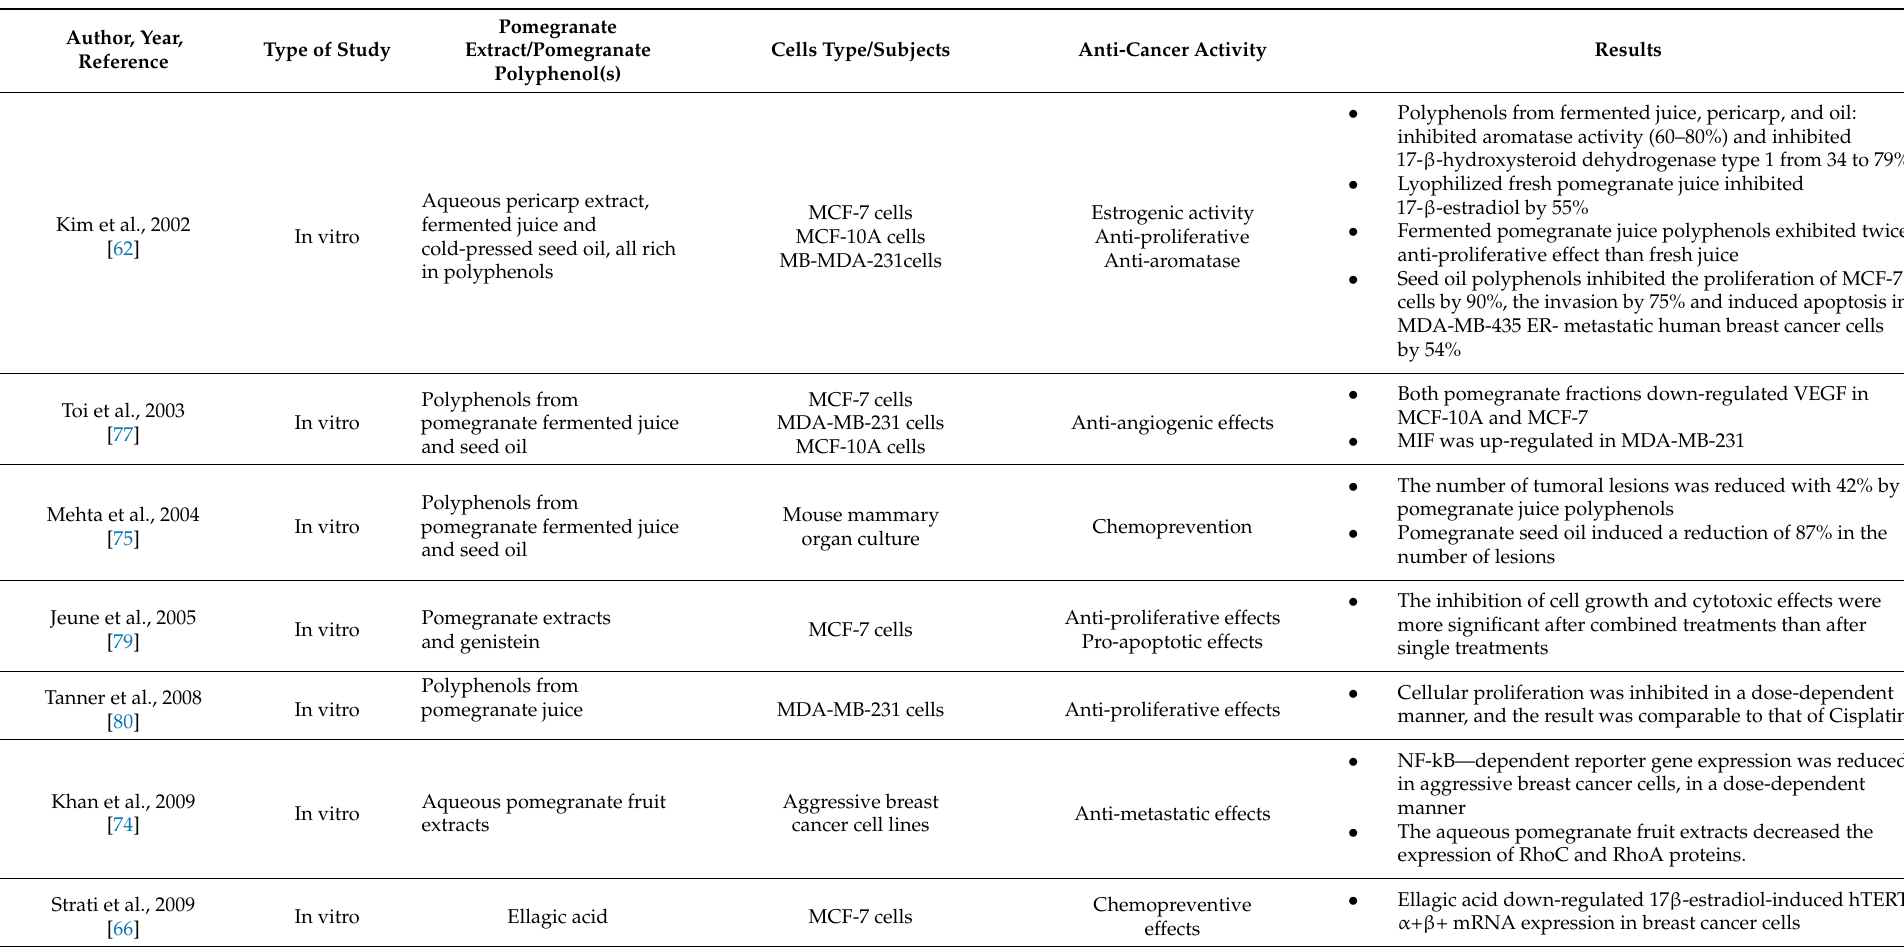
Table 1. Studies regarding anti-breast cancer activity of Punica